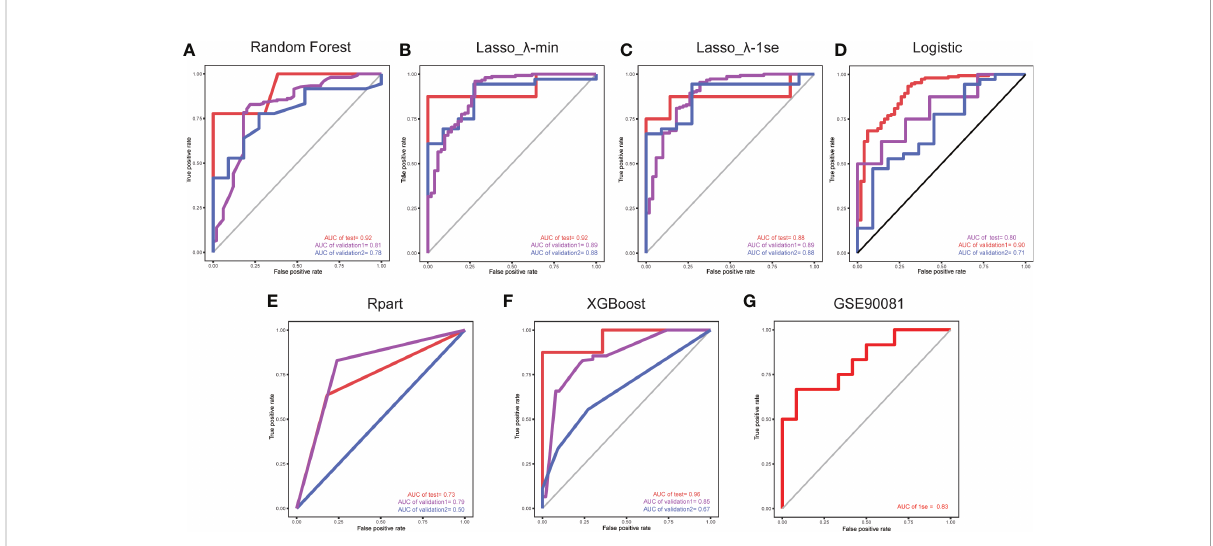
FIGURE 2 ROC curves for validation set 1 and validation set 2, with the model trained on a separate set. The red lines indicate the models trained using a LOO cross-validation approach across the training set. We used fi ve methods to develop models based on the training set: (A) a random forest wrapper (Boruta), (B) LASSO_ l -min, (C) LASSO_ l -1se, (D) logistic regression, (E) regression partition trees (Rpart) and (F) extreme gradient boosting (XGBoost). (G) ROC curve of the LASSO_ l -1se model in whole blood